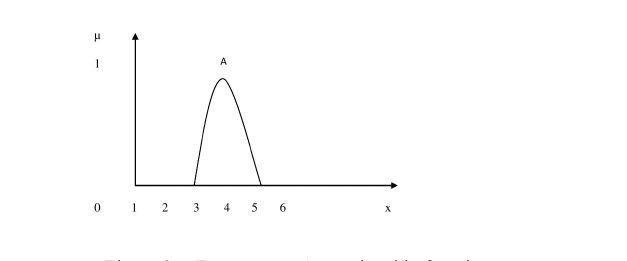
Figure 3. Fuzzy group A membership function.